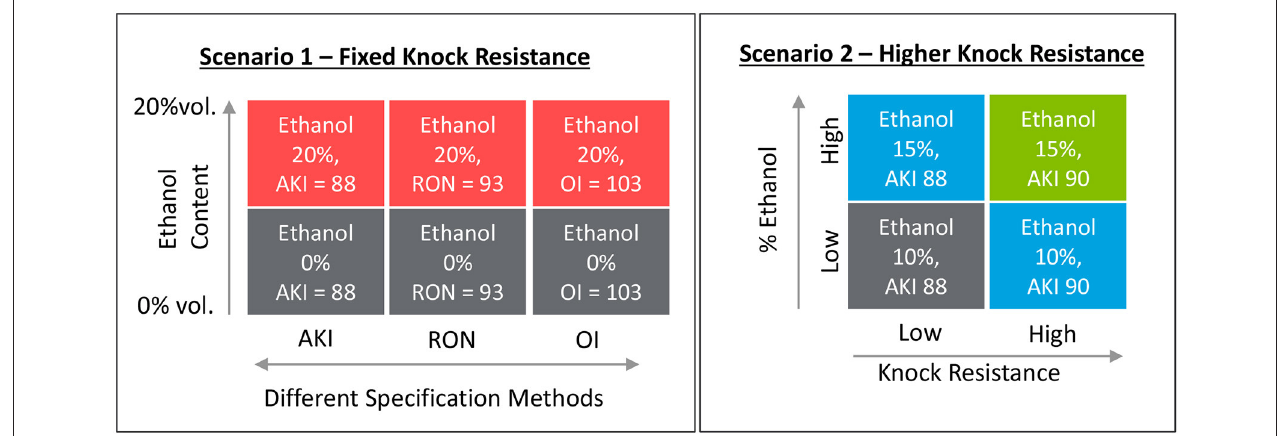
FIGURE 2 | Summary of scenarios 1 and 2 evaluated in this